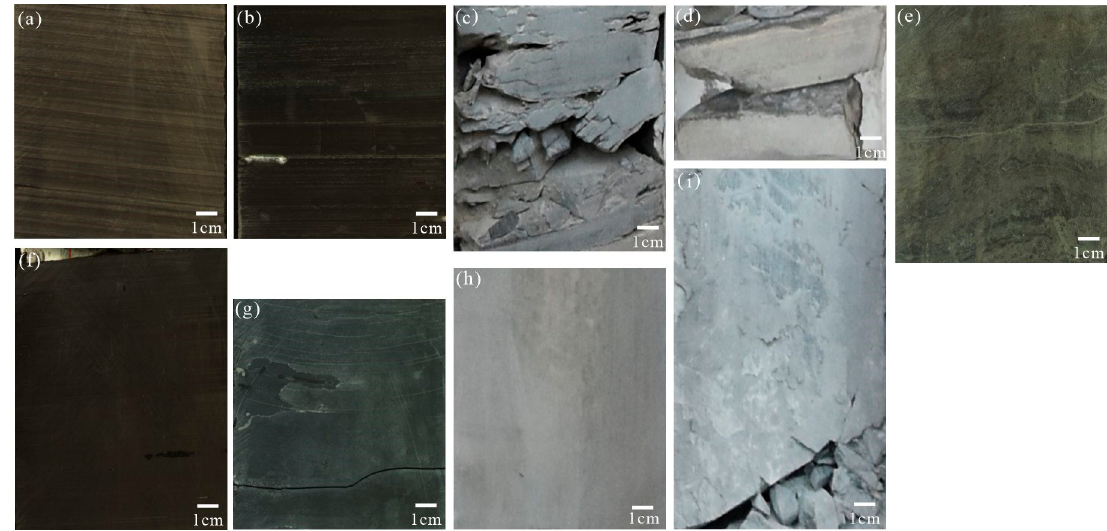
Figure 3. ( a ) Middle-high organic laminated calcareous fine-grained sedimentary rocks. Well NY1, 3419.40 m. ( b ) Middle-high organic laminated mixed fine-grained sedimentary rocks. Well NY1, 3411.20 m. ( c ) Middle-high organic flaggy mixed fine-grained sedimentary rocks. Well G17X10, 3200.15 m. ( d ) Middle-high organic flaggy calcareous fine-grained sedimentary rocks. Well G17X10, 3211.30 m. ( e ) Middle-high organic massive calcareous fine-grained sedimentary rocks. Well FY1, 3430.8 m. ( f ) Middle organic massive mixed fine-grained sedimentary rocks. Well NY1, 3449.30 m. ( g ) Low organic massive argillaceous fine-grained sedimentary rocks. Well NY1, 3471.24 m. ( h ) Low organic massive felsic fine-grained sedimentary rocks. Well G17X10, 3226.90 m. ( i ) Low organic massive mixed fine-grained sedimentary rocks. Well G17X10, 3230.05 m.